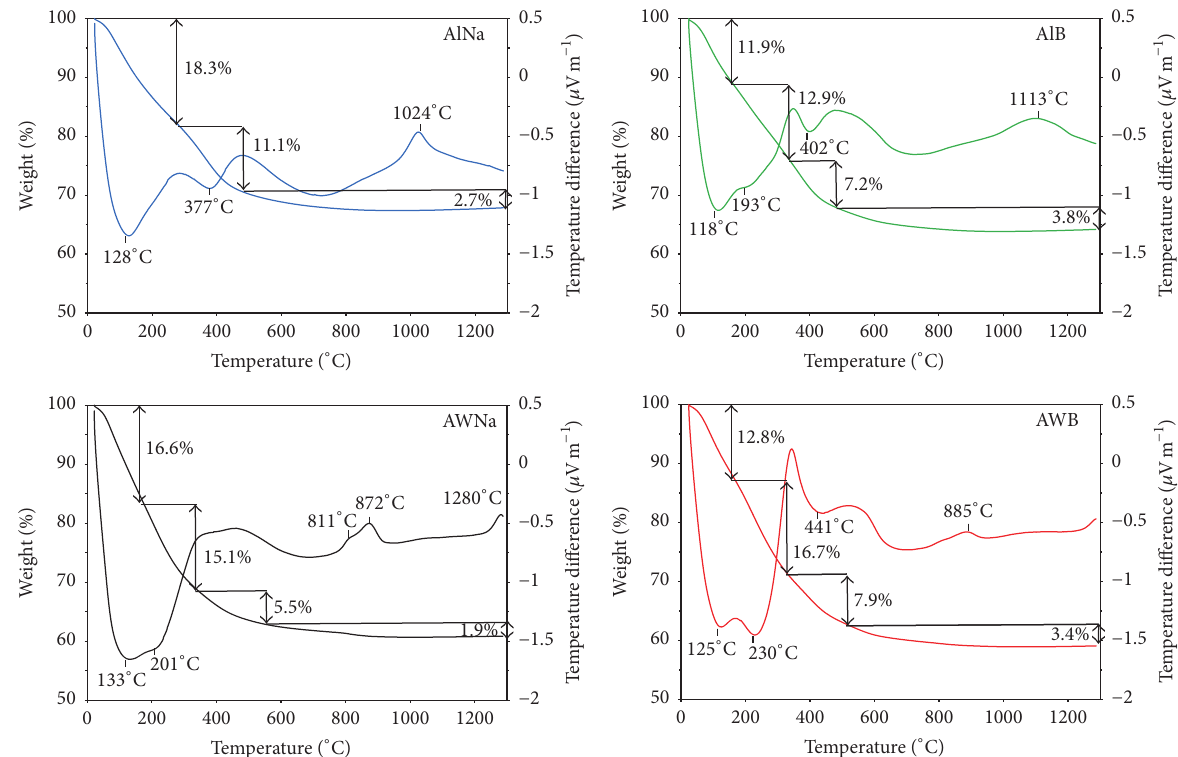
Figure 4: TG and DTA curves of the boehmites obtained AlCl 3 ⋅ 6H 2 O (AlNa, with NaOH, and AlB, with n-butylamine) and aluminum waste (AWNa, with NaOH, and AWB, with n-butylamine).